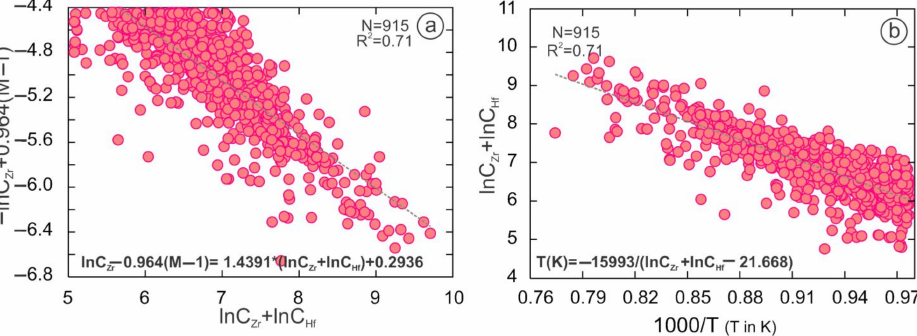
Figure 8. ( a ) lnC Zr + lnC Hf to lnC Zr + 0.964(M–1) and 1000/T (T in K) show a negative correlation ( b ) Accordingly, C Zr + C Hf in bulk composition could be related to the temperature. (n = 915, and M < 2 http://georoc.mpch-mainz.gwdg.de/georoc/, accessed on 29 August